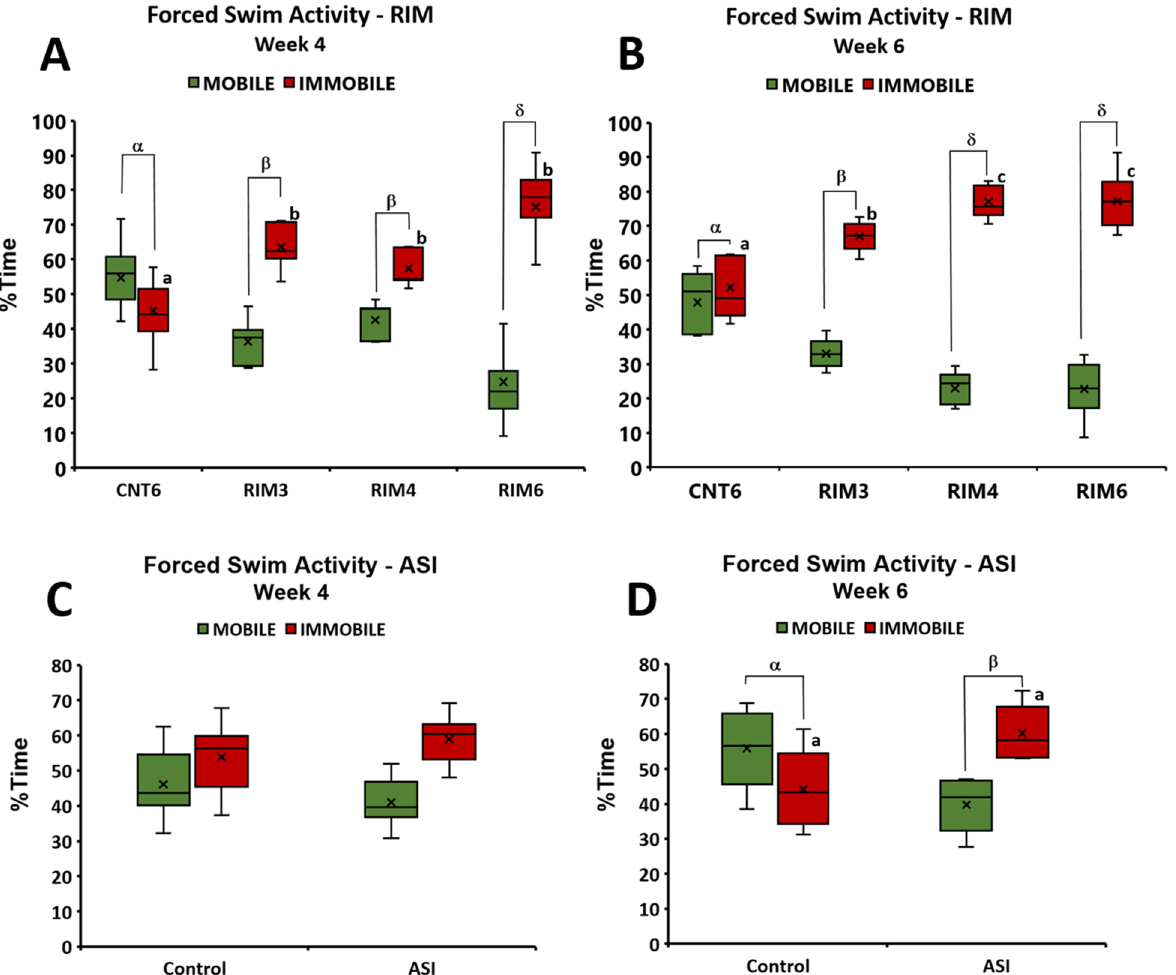
Figure 6. Percentage of immobility and mobility time in the forced swimming test in mice subjected to reserpine-induced myalgia and intramuscular acid saline solution injection. Data are expressed as median ± IQR, and the mean is also shown as a x. a–b: Groups not sharing a letter showed significant differences in %Immobility time, p < 0.05; α–β: Groups not sharing a letter showed significant differences in %Immobility- %Mobility time p <